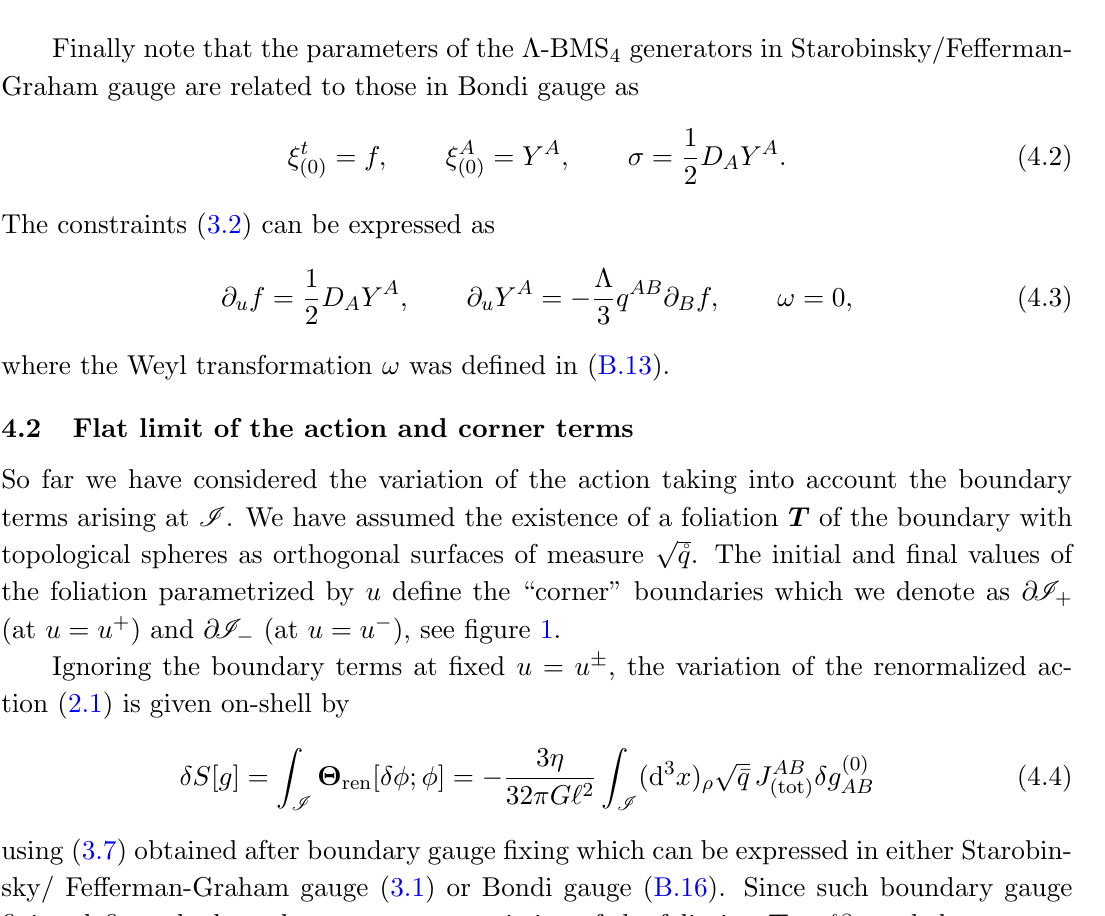
Figure 1. Geometry of Al(A)dS 4 boundaries with background